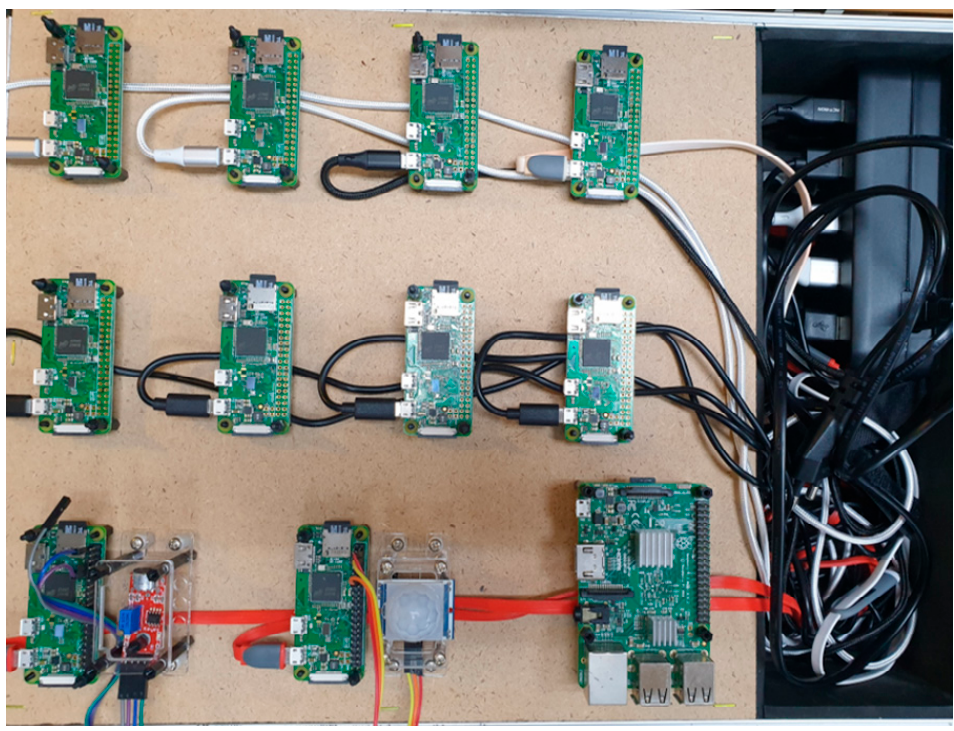
Figure 13. Experimental setup implemented for encryption and decryption.